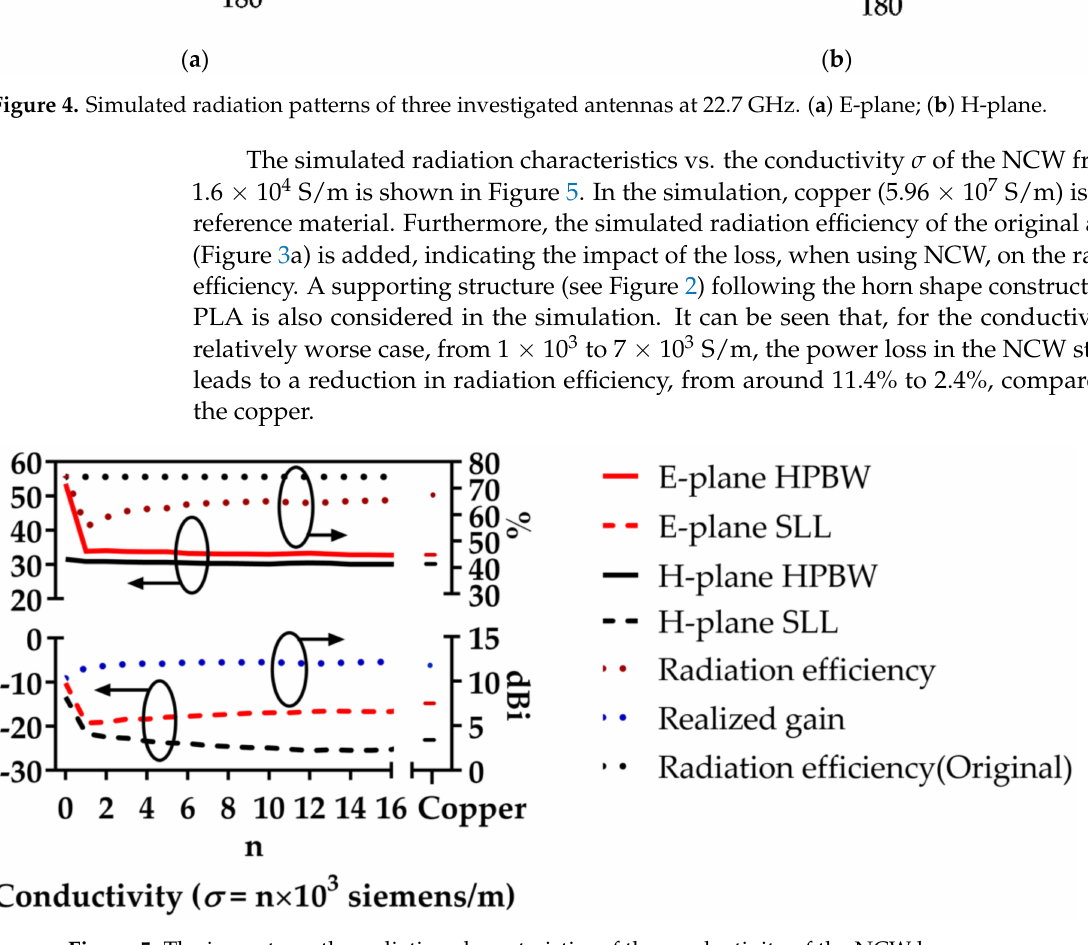
Figure 5. The impacts on the radiation characteristics of the conductivity of the NCW